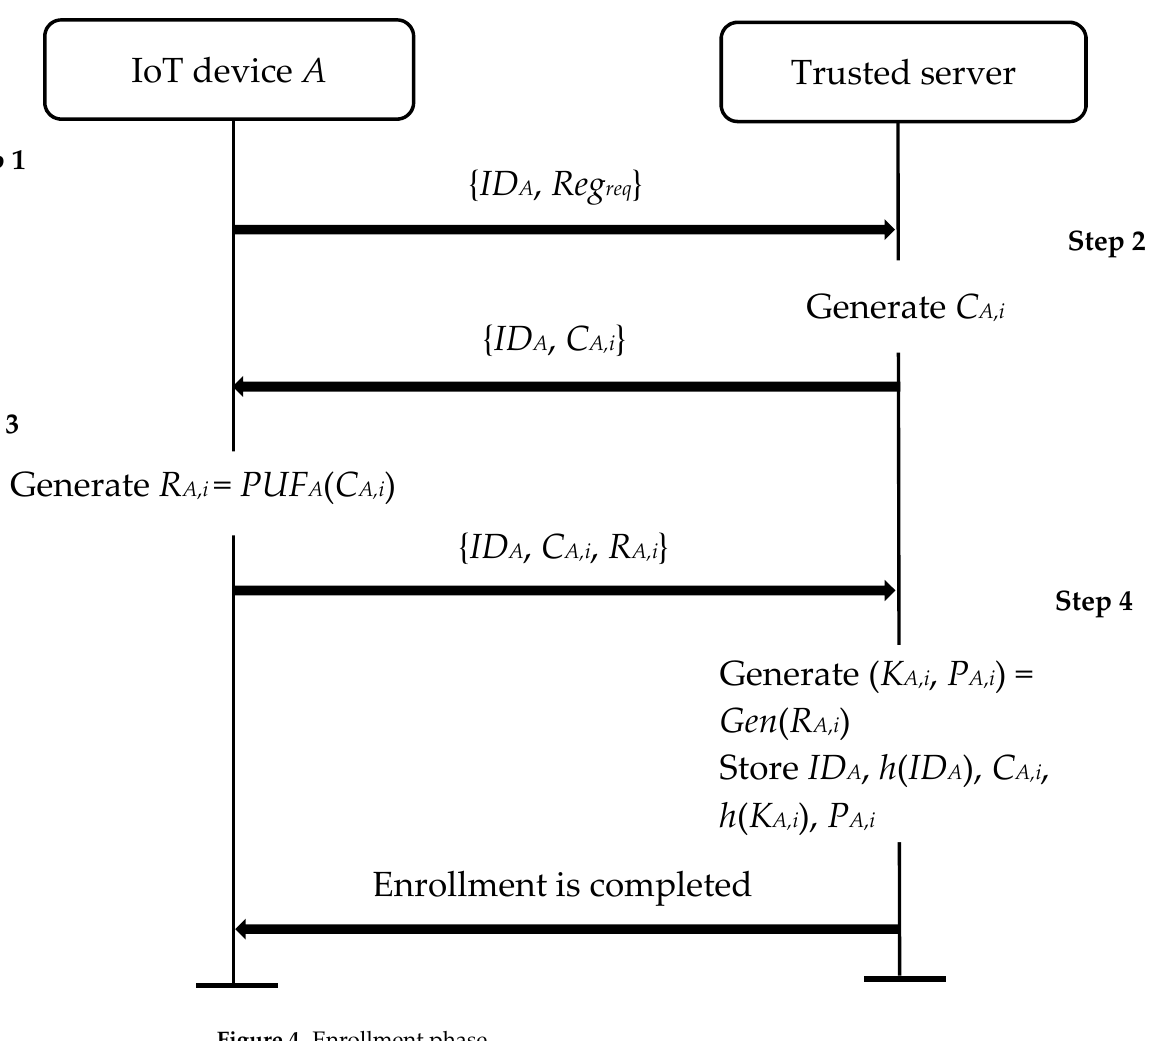
Figure 4. Enrollment phase.